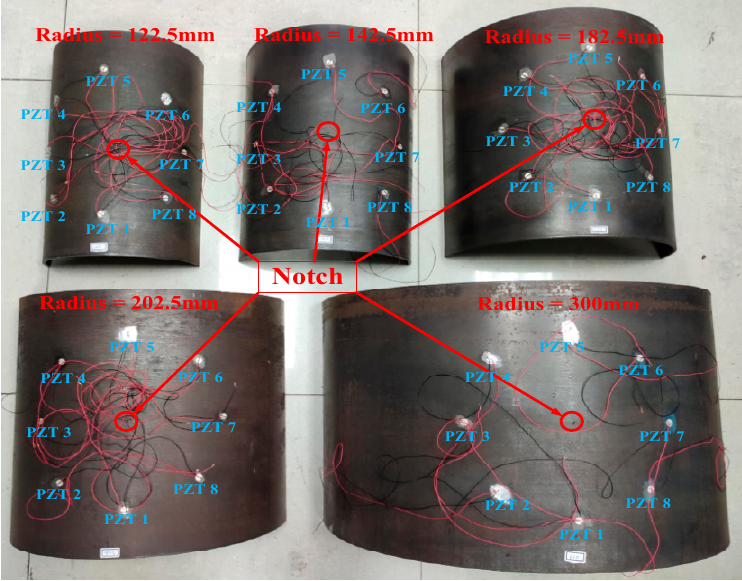
Figure 11. Curved plates with different radius. Table 2. Parameters of curved plates with different radius.